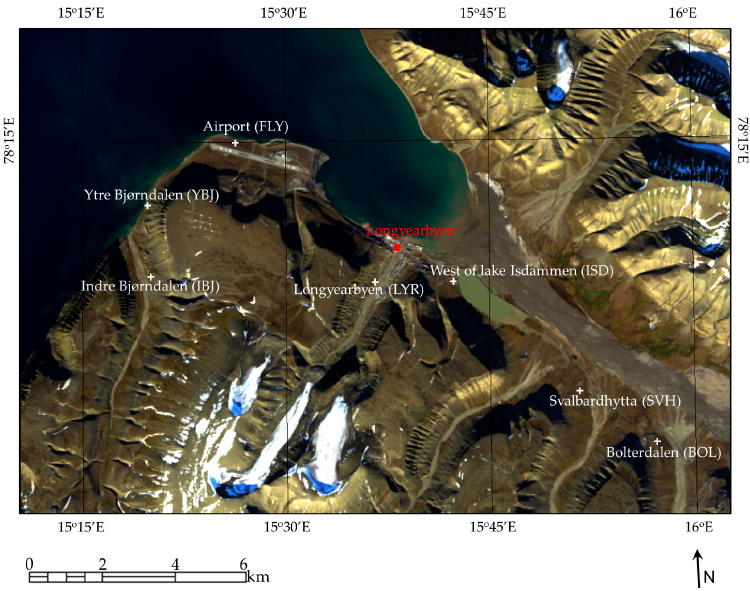
Figure 1. Sampling sites near Longyearbyen on the main island in Svalbard. YBJ, FLY and ISD